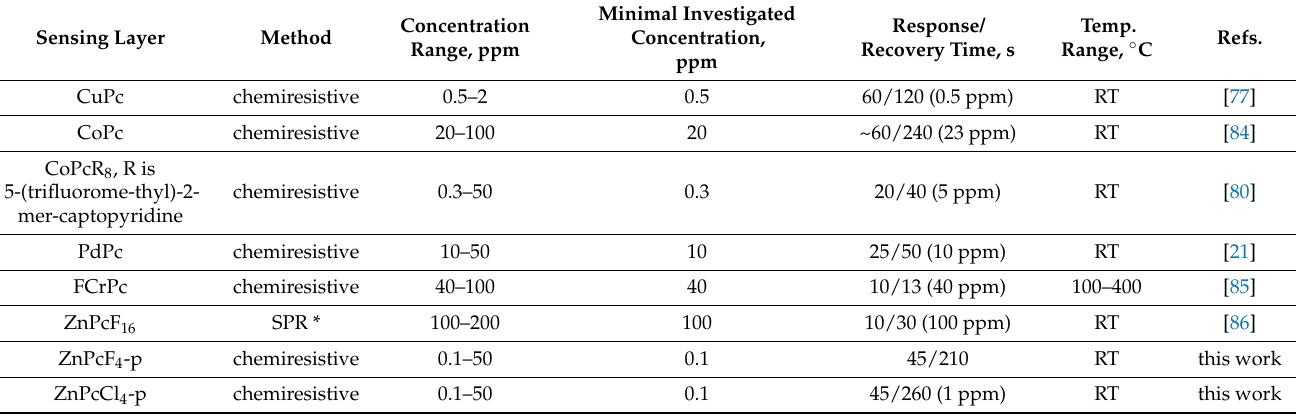
Table 4. Sensor characteristics of various phthalocyanines toward